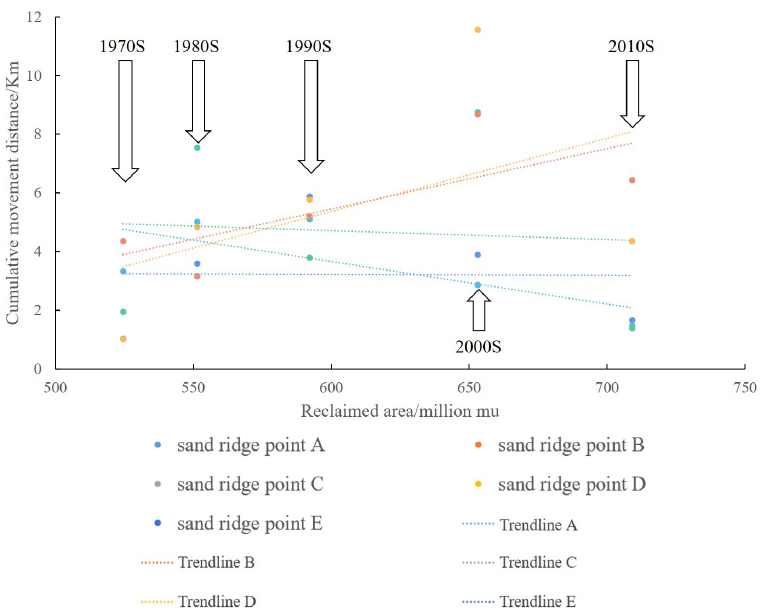
Figure 15. The response of sand ridge points movement of Dongsha Shoal to the reclamation in Yancheng.